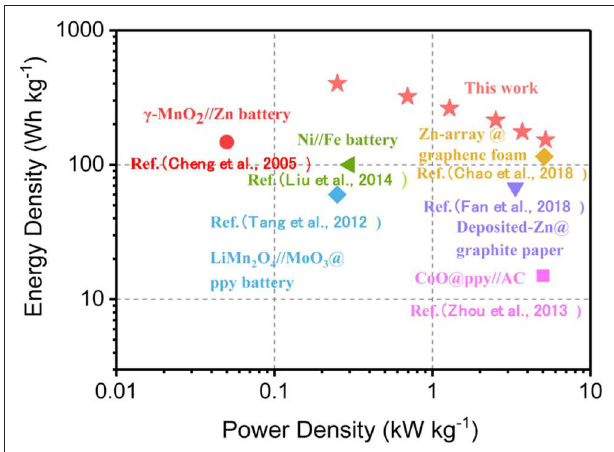
FIGURE 4 | Ragone plots of the 3DPG//3DPG SCs and other recently reported energy storage devices for comparison.